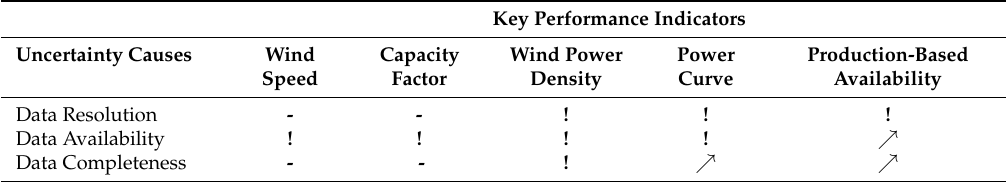
Table 1. The effect of the evaluated uncertainty causes on different KPIs. Key Performance